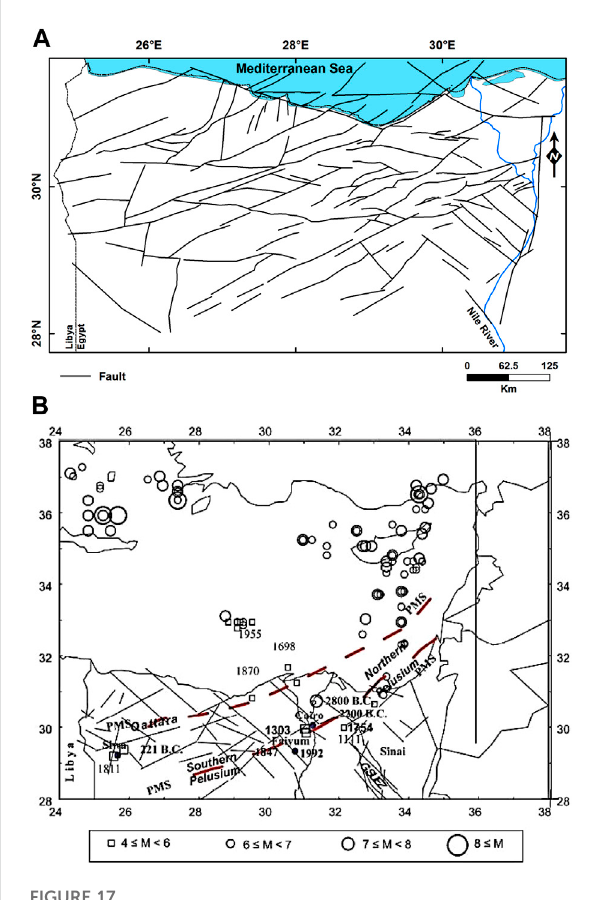
(A) Structural architecture of the basement and Jurassic rocks in north Western. Desert by the El Paso exploration and production company (Wescott et al., 2011). (B) Historical and important earthquakes triggered by the PMS in the time period 2800 BC- 1995 AD. (PMS = PMS as detected from this study, Thin lines = shear faults detected from gravity). (Compiled by Gamal, 2013 from, Maamoun, 1979; Maamoun et al., 1984; Ben-Menahem, 1979; Riad et al., 1983 and (Woodward-Clyde,